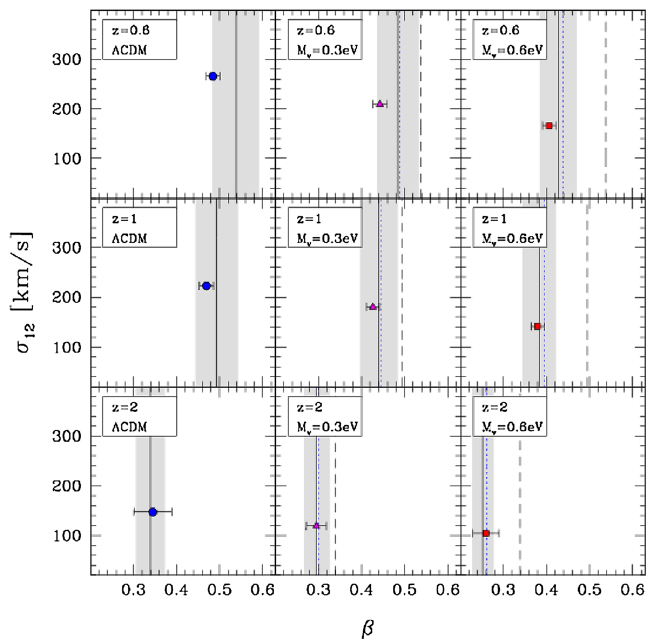
Fig. 48 Best-fit values of β - σ 12 , as a function of Σ and redshift (points), compared with the theoretical prediction (greyshaded area).The blue dotted linesshowthe theoretical prediction fora Λ CDM cosmology normalised to the σ 8 value of the simulation with a massive neutrino component